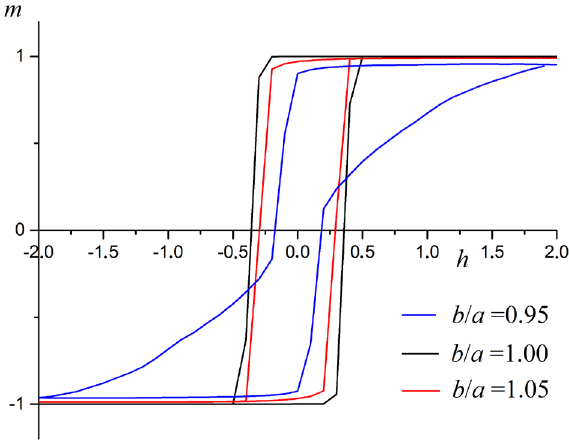
Figure 4. Hysteresis loops for three different film and substrate period ratios at A = 0.1 , r 0 = 0.1 .